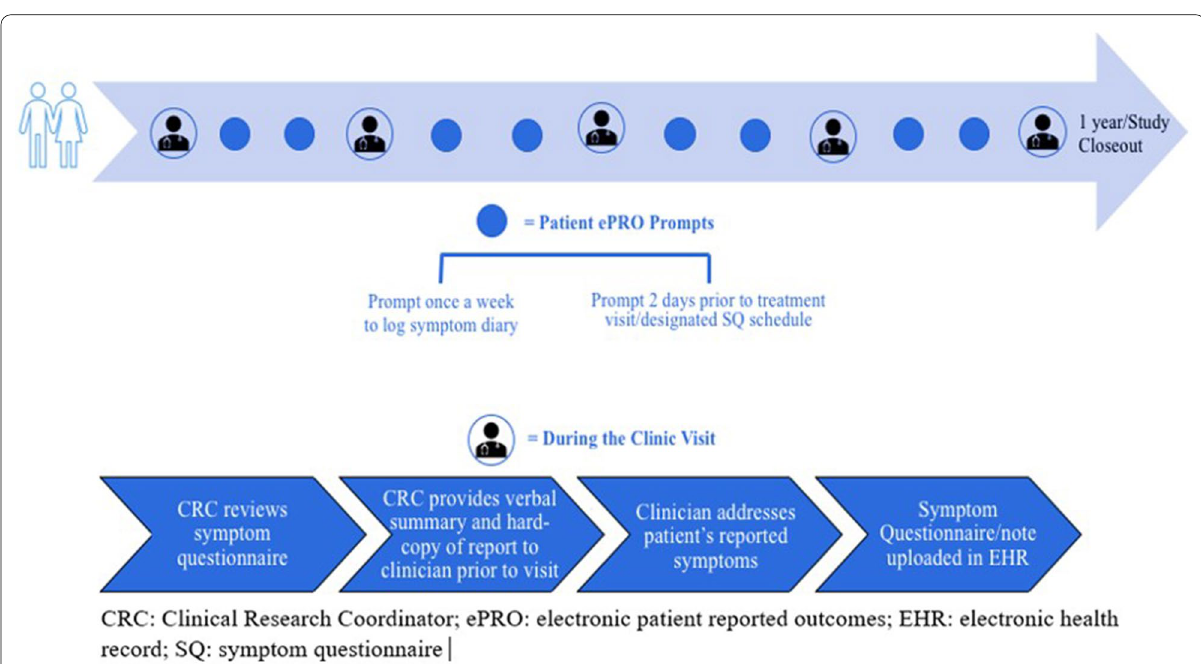
Fig. 2 Schema of ePRO intervention. Overall schema of the ePRO intervention with symptom logs, questionnaires, and in-clinic review. For example, patients on cytotoxic regimens such as FOLFOX for colorectal cancer received infusions every two weeks and were thus prompted to complete a SQ every two weeks. Patients on oral medications might not be seen in clinic as frequently and were thus prompted to complete a SQ by a scheduled clinic visit and at a minimum of every three